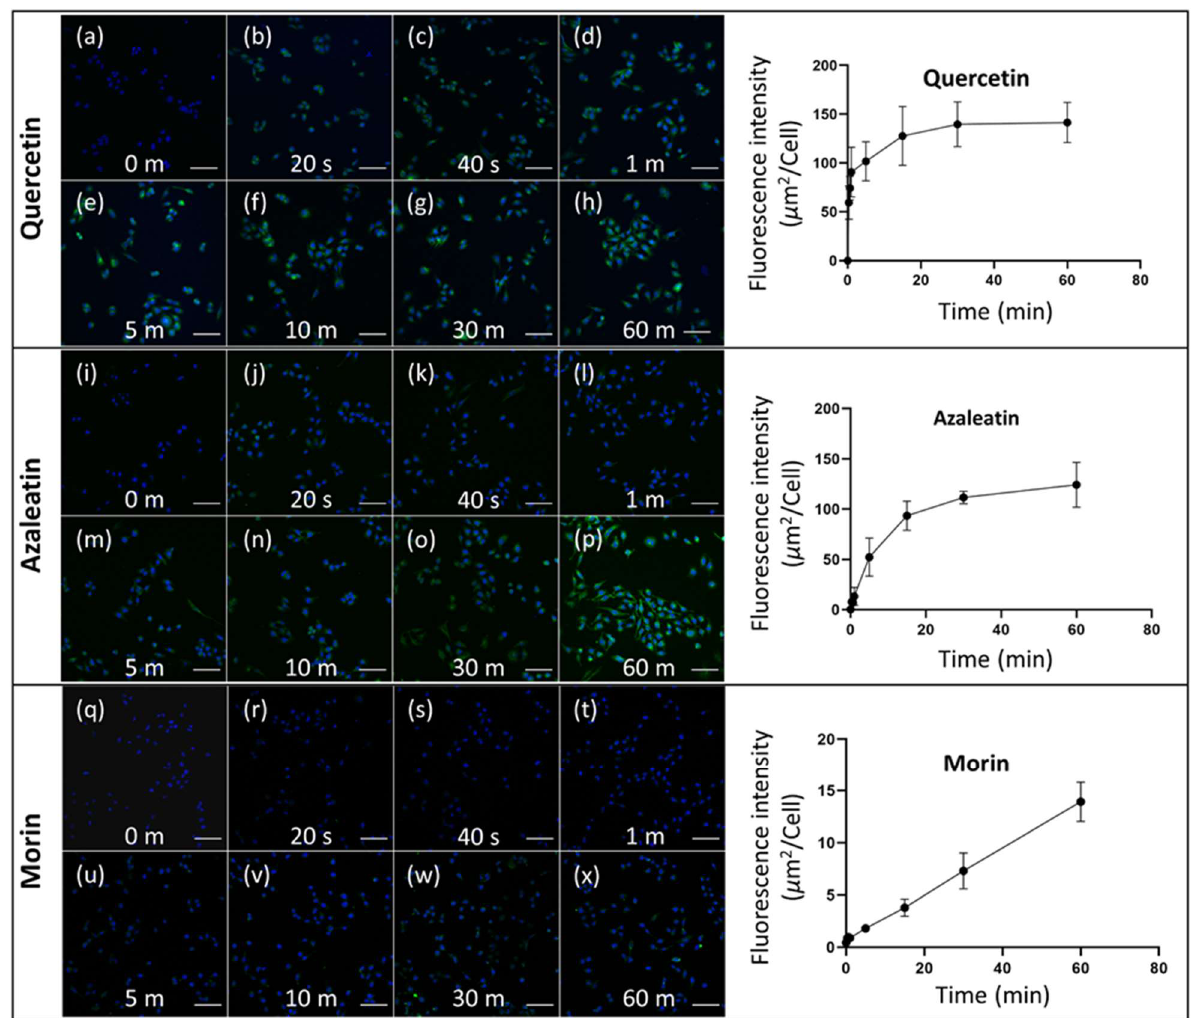
Figure 8. Fluorescent microscopic images of flavonoid uptaken SH-SY5Y cells treated with DPBA for various durations, ( a – h ) quercetin, ( i – p ) azaleatin and ( q – x ) morin. Increase in fluorescence intensity as a function of treatment time are presented for each flavo.